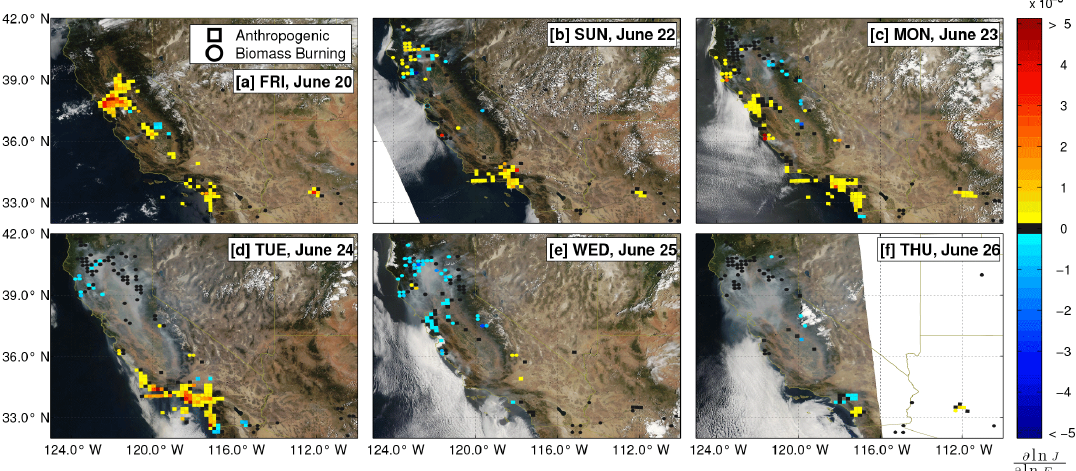
) of the 4D-Var cost function (for surface and aircraft observations) with respect to anthro- Figure 10. Normalized sensitivities ( ∂ ln J ∂ ln E i,j,d pogenic and burning emission scaling factors overlaid on MODIS Aqua true color images for 6 days during the simulation. Anthropogenic sensitivities with magnitudes less than 1% of the maximum anthropogenic sensitivity magnitude are removed. There is a marker for all grid cells with non-zero burning